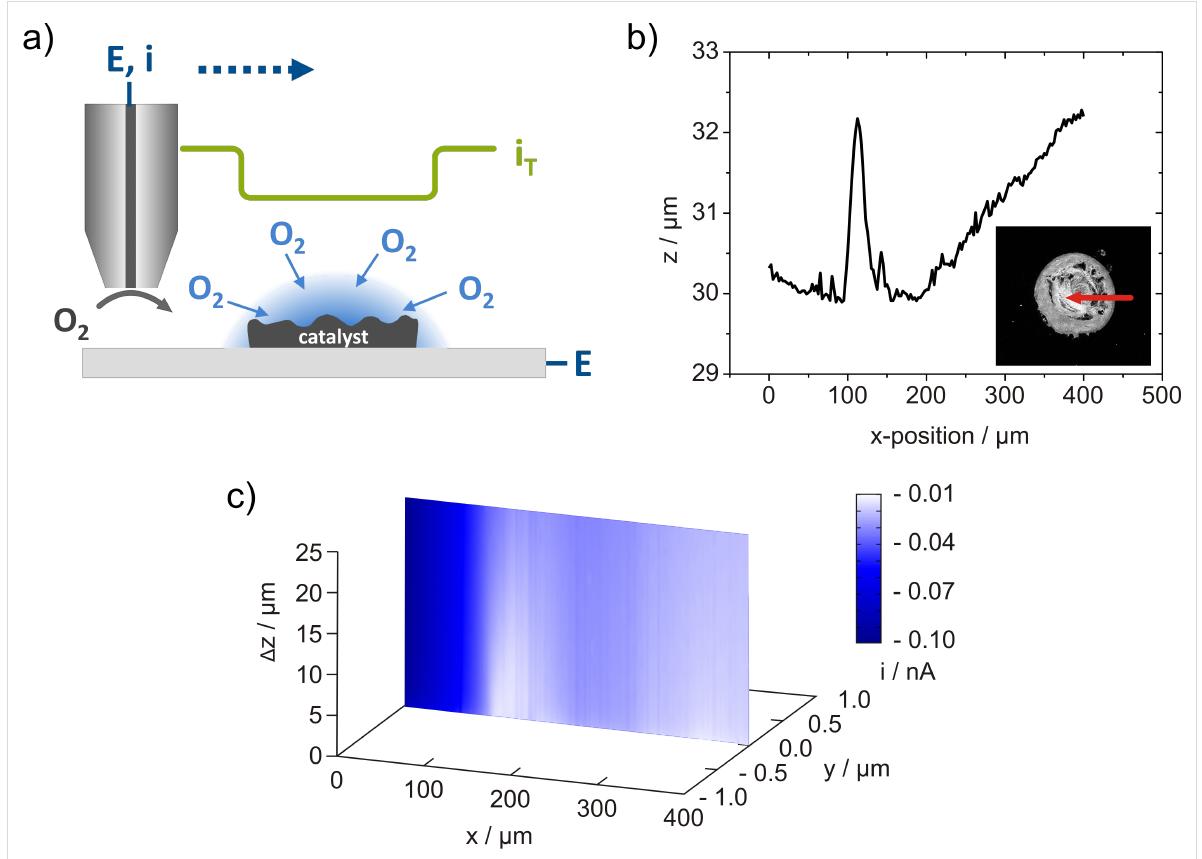
Figure 1: 4D SF/CD-SECM for the investigation of the catalytic activity towards oxygen reduction. a) Scheme of the competition mode. b) Topo- graphic linescan across a spot of Pt/C catalyst with 20 wt % Pt on a glassy carbon plate obtained in the shearforce-based cd-mode of SECM. The topography is displayed as the z-piezo position of the tip after reaching the predefined stop criterion of the shearforce interaction (point of closest ap- proach). The insert shows an optical micrograph of the investigated spot and the arrow marks the scan position and direction. c) Oxygen consump- tion profile above the line displayed in b) visualized as a x, Δ z,i-image, where Δ z represents the distance of the current detection from the point of shearforce interaction. E sample = − 300 mV, E tip = − 600 mV, d tip = 0.8 µm, f osc = 356.7 kHz, stop criterion: 5% change of the lock-in signal in